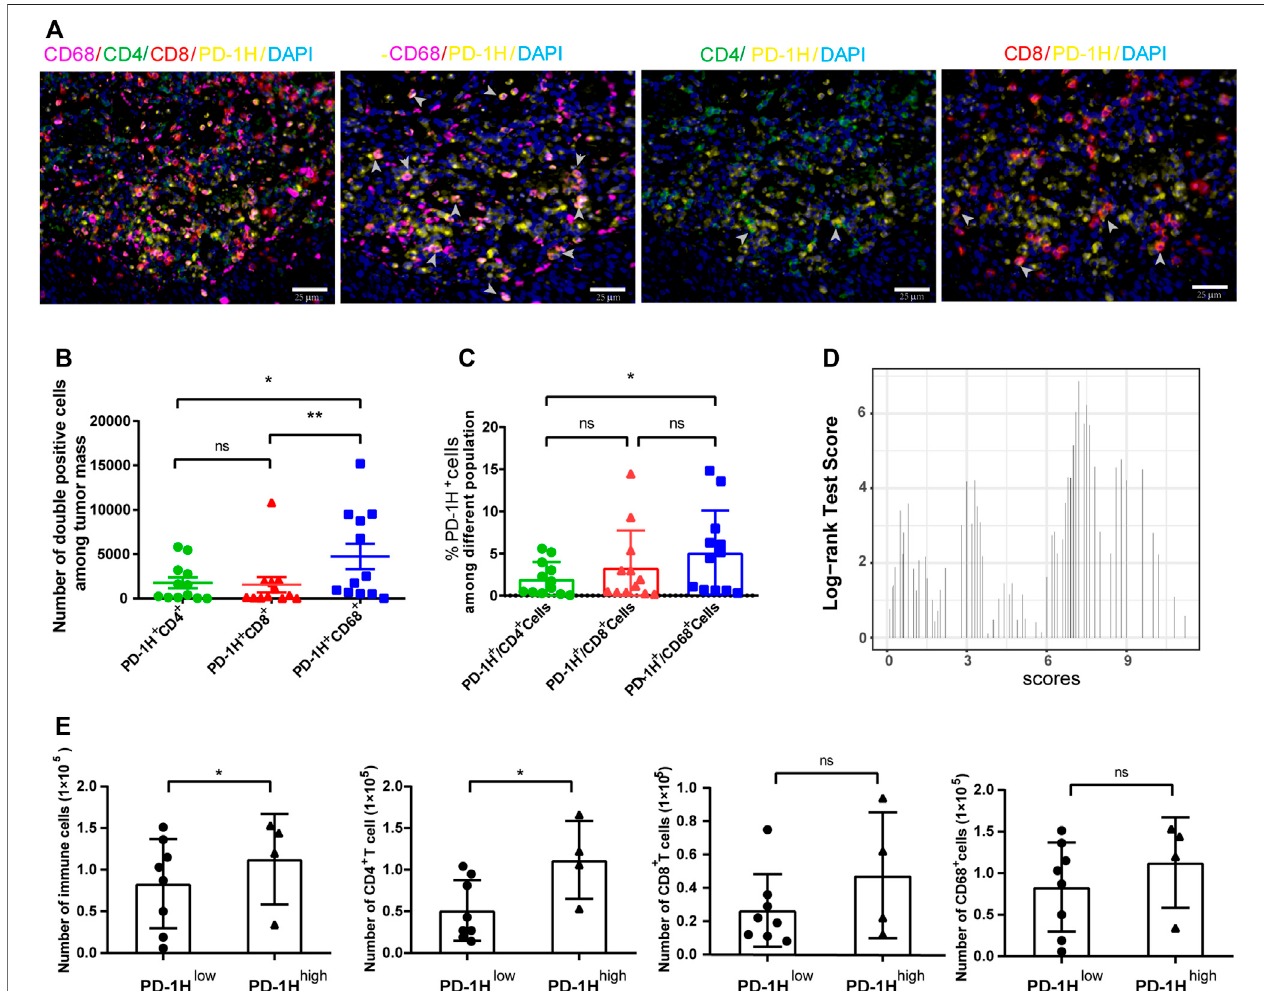
FIGURE2| PD-1Hexpressionintumor-in fi ltratingimmunecellsassessedbymultipleximmunohistochemistry(mIHC). (A) RepresentativeimagesofmIHC staining ofPD-1H,CD4,CD8,CD68,and DAPIinESCCtumortissues.Scalebar:25 μ m,originalmagni fi cation × 400. (B) ThecellnumbersofPD-1H + CD68 + myeloidcellswere signi fi cantlyhigherthancellnumbersofPD-1H + CD4 + andPD-1H + CD8 + cells. (C) Thepercentage ofPD-1HpositivecellsamongCD4 + Tcells,CD8 + Tcells,andCD68 + cells was estimated. (D) The expression score of PD-1H was calculated and classi fi ed into high-expression (PD-1H high ) or low-expression (PD-1H low ) groups by using the R package of “ survMisc ” . (E) The absolute counts of immune cells and CD4 + T cells in tumor sites were signi fi cantly higher in patients with high PD-1H expression than in patients with low PD-1H expression. ns (cid:2) non-signi fi cant, * p < 0.05, ** p <